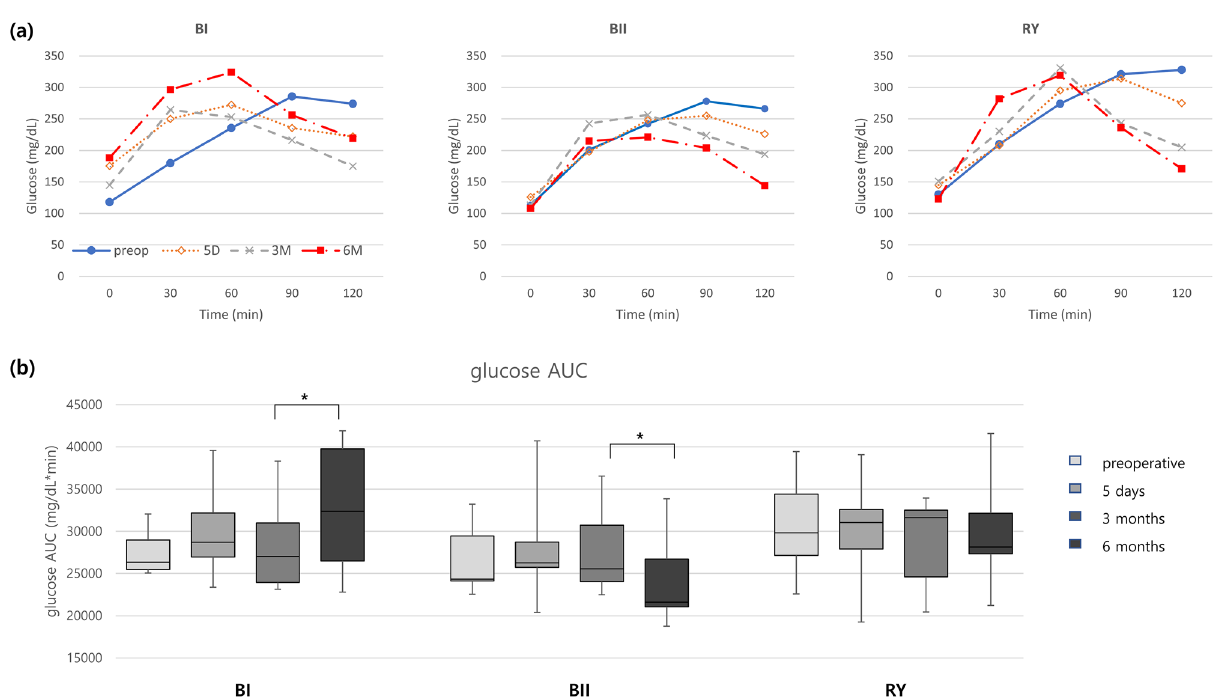
Figure 5. ( a ) Dynamic changes of serum glucose level after oral glucose tolerance test (OGTT) in each group. ( b ) Area under curve (AUC) during OGTT (*p < 0.05; BI Billroth I, BII Billroth II, RY